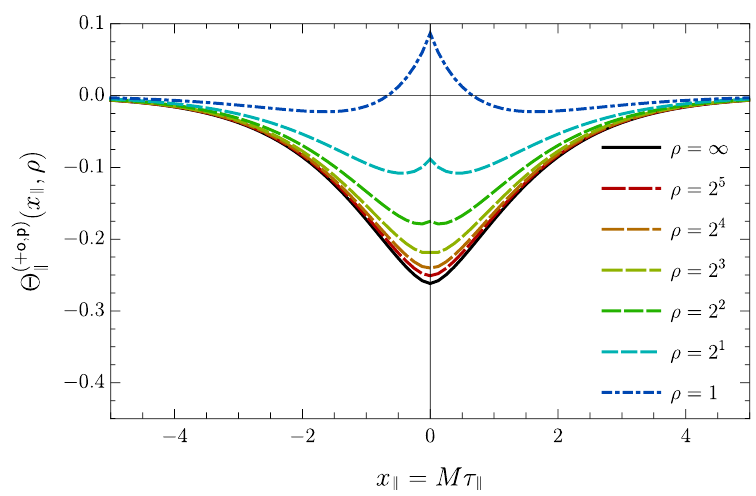
(+ o , p ) ( x , ρ ) of the free energy for different values of Figure 12: Scaling function Θ aspect ratios ρ ≥ 1. For ρ (cid:54) = ∞ there is a kink at x δ = 0 present and, in con- trast to the periodic systems we discussed before, the scaling function converges to zero for all aspect ratios in both the ordered and the unordered phase due to the unambiguously broken Z 2